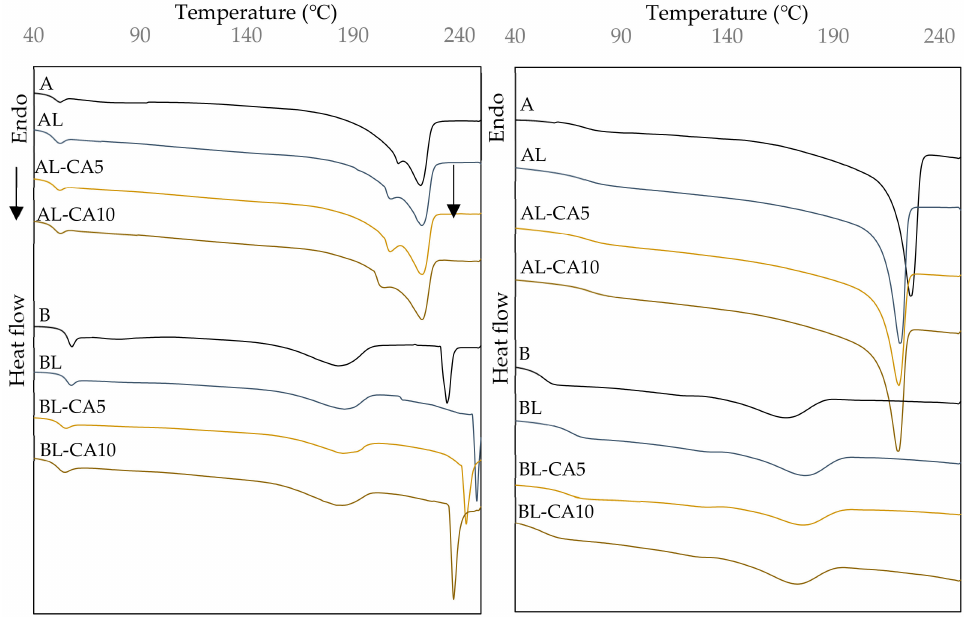
Figure 5. Di ff erential scanning calorimetry (DSC) curves of the PVA films (A and B) with and without carvacrol (5 or 10 g / 100 g PVA) previously encapsulated in lecithin (L). On the left, the first heating scan and on the right the second heating